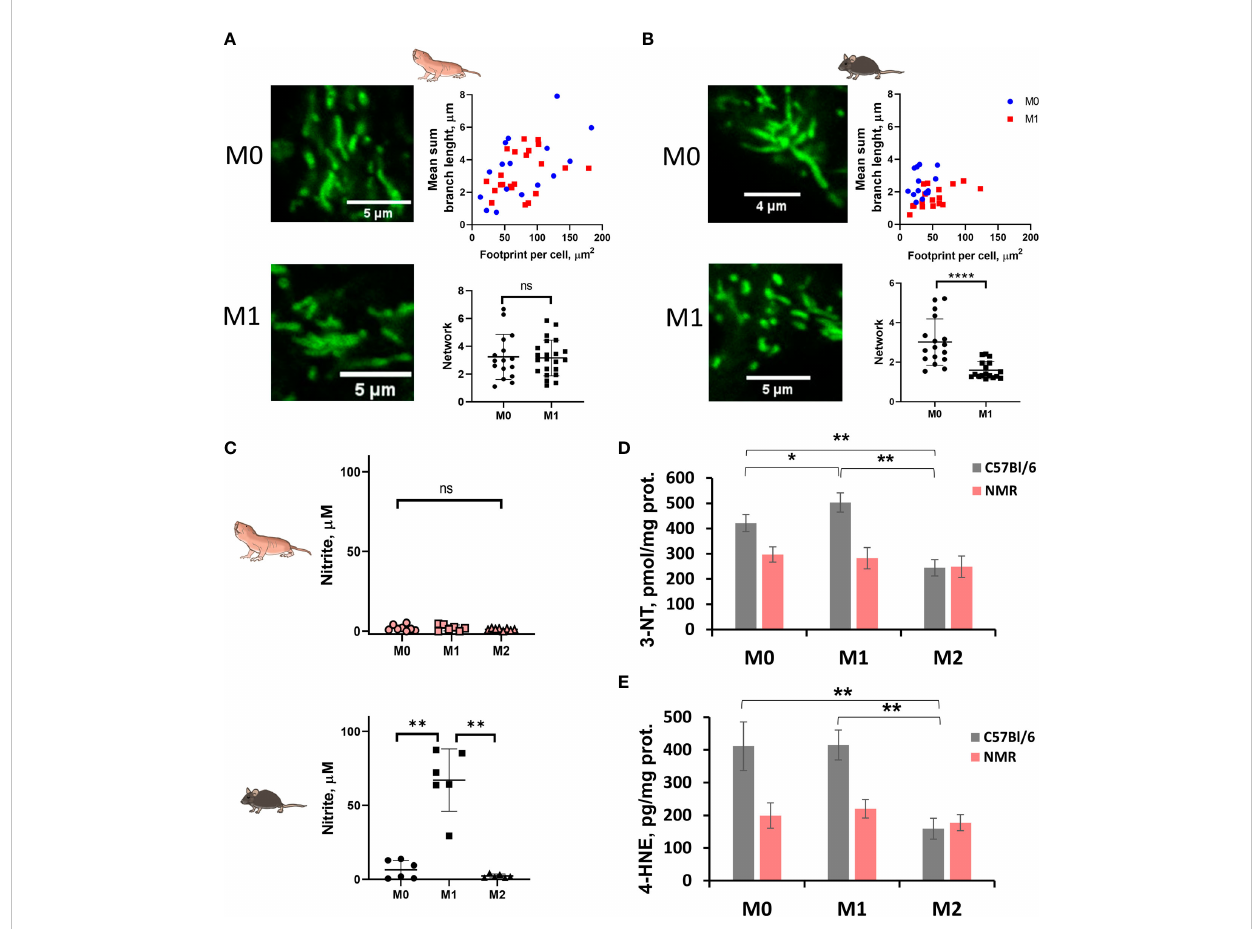
FIGURE 3 M1-polarized NMR macrophages are characterized by signi fi cant reduction in NO production accompanied by less pronounced mitochondrion fi ssion. Representative image of MitoTracker Green stained mitochondria of M0 and M1 NMR (A) and murine macrophages (B) and their structural parameters analyzed with MiNA software for ≥ 20 individual cells. (C) Nitrite concentration in supernatants of NMR BMDMs activated by LPS (10 ng/ mL) and mouse recombinant IFN g (10 ng/mL) (M1) or mouse recombinant IL-4 (M2) for 24 h. Nitrite concentration in control mouse BMDMs activated in the same conditions except for temperature (37°C); (D) 3-nitrotyrosine content in cell lysates of NMR and mouse BMDMs activated by LPS (10 ng/mL) and mouse recombinant IFN g (10 ng/mL) (M1) or mouse recombinant IL-4 (M2) for 24 h (E) 4-hydroxynonenal concentration in cell lysates of NMR and mouse BMDMs. Results displayed as mean ± SD. *p<0.05; **p< 0.01; ****p<0.0001; ns-not signi fi cant, one-way RM-ANOVA or Student ’ s